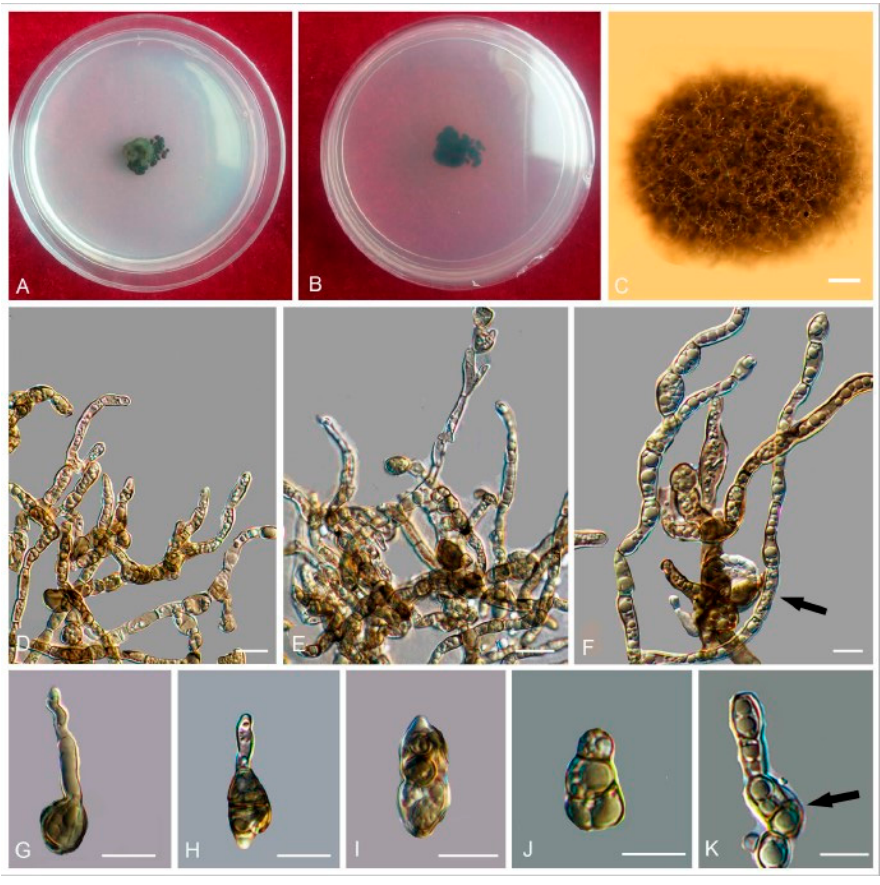
Figure 7. Anthracina saxincola (CGMCC3.17315). ( A – C ) Colony forward and reverse after 20 weeks on MEA. ( D , E ) Different hyphal morphologies. ( F ) Swollen cell (arrow). ( G ) Unicellular body with hypha. ( H – J ) Solitary, enlarged, dark-pigmented multicellular bodies. ( K ) Endoconidia in intercalary cells of hyphae (arrow). Scale bars ( C ) = 50 μ m and ( D – K ) = 10 μ m. Etymology: saxincola (Lat., fem. adj.), referring to a stone inhabitant.